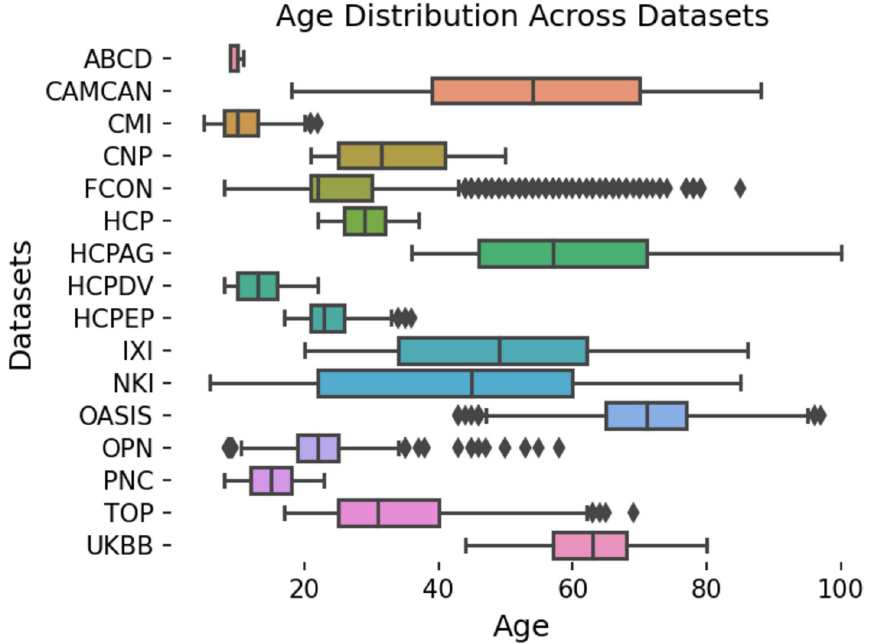
Fig 5. The age span of participants across 16 neuroimaging datasets. Our experimental data cover almost the full range of human life-span.